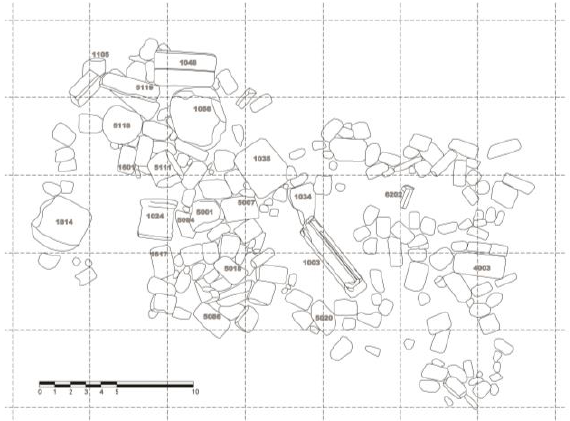
Figure 14. 2D drawing from the orthophoto of 750 m2 (Mohamed